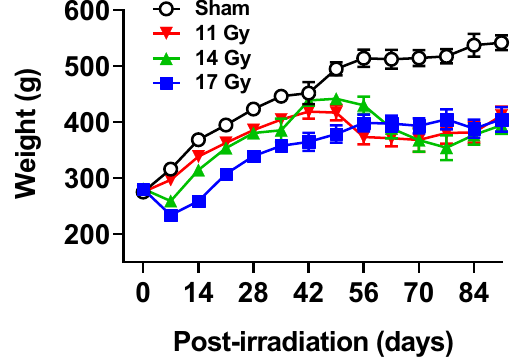
Figure 1. Body weights (mean ± SEM) of proton irradiated and control rats. There were no differences in weight at the time of irradiation. Regardless of dose, irradiated rats had decreased body weights ( p < 0.0001). The 11 Gy rats had decreased weights at 5 weeks, no difference at 6 weeks, and decreased weights the rest of the testing period compared with controls.. The 14 Gy and 17 Gy rats had decreased weights at week 1 until the end of testing with the exception of week 6 in the 14 Gy rats when there was no difference compared with controls. n = 10/group for sham controls, 11 Gy, and 17 Gy and 8–10 for 14